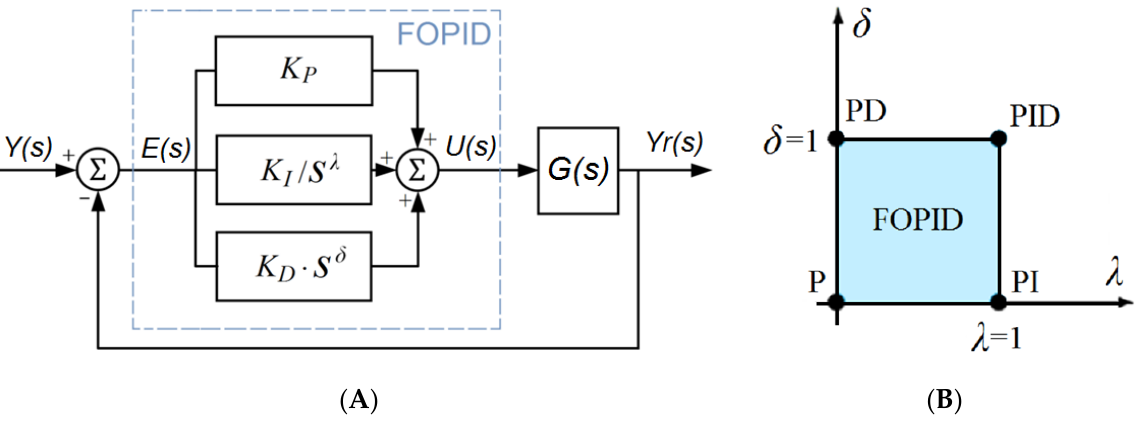
Figure 3. The FOPID controller: ( A ) structure in a control loop; ( B ) graphical presentation in δ – λ plane.